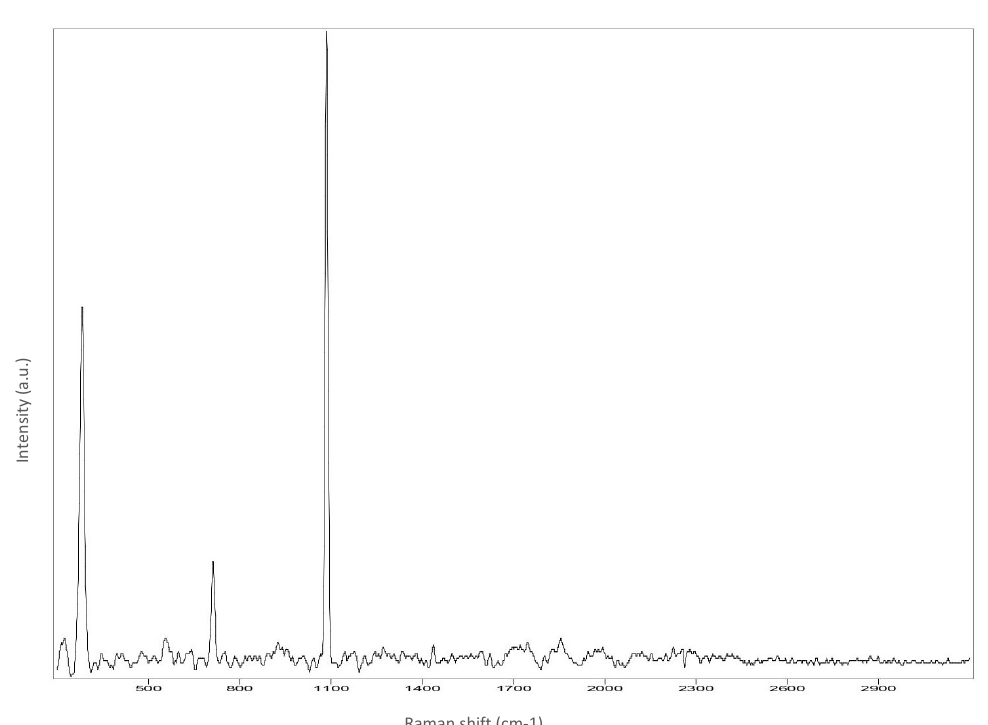
Raman shift (cm-1)